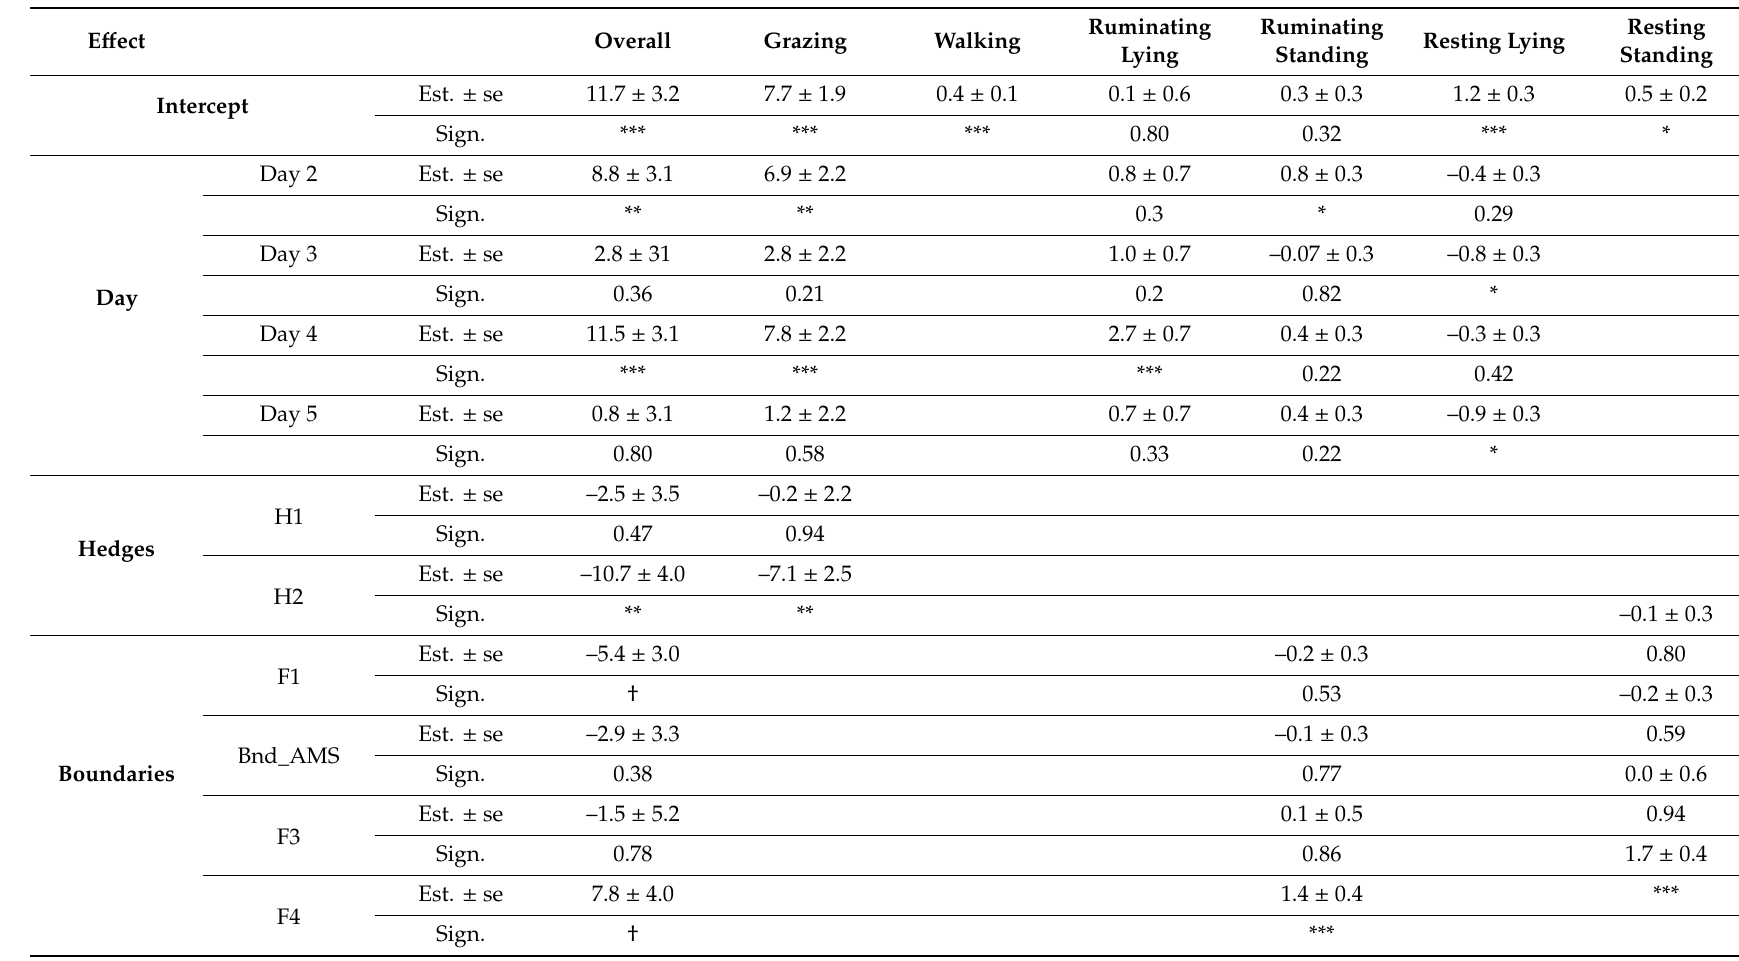
Table A5. Estimates and significance levels associated with the pasture characteristics and the day of grazing for the temporary grassland. E ff